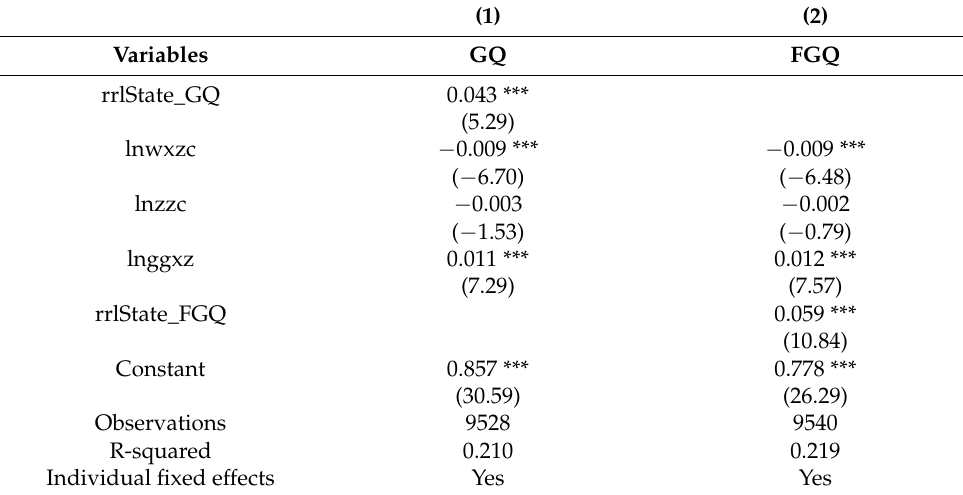
Table 6. Heterogeneity analysis on the nature of enterprise ownership based on OLS.